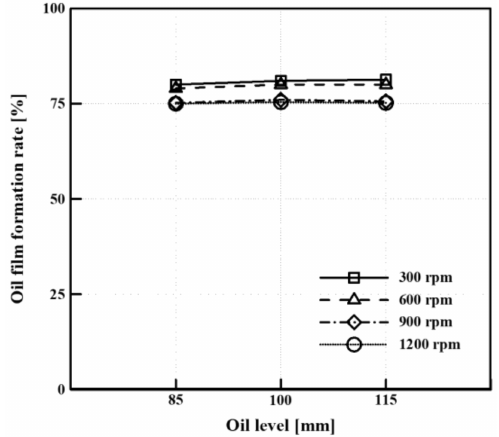
Figure 11. Oil film formation rate according to oil level at 60 ◦ C, 0.084 kg/s.